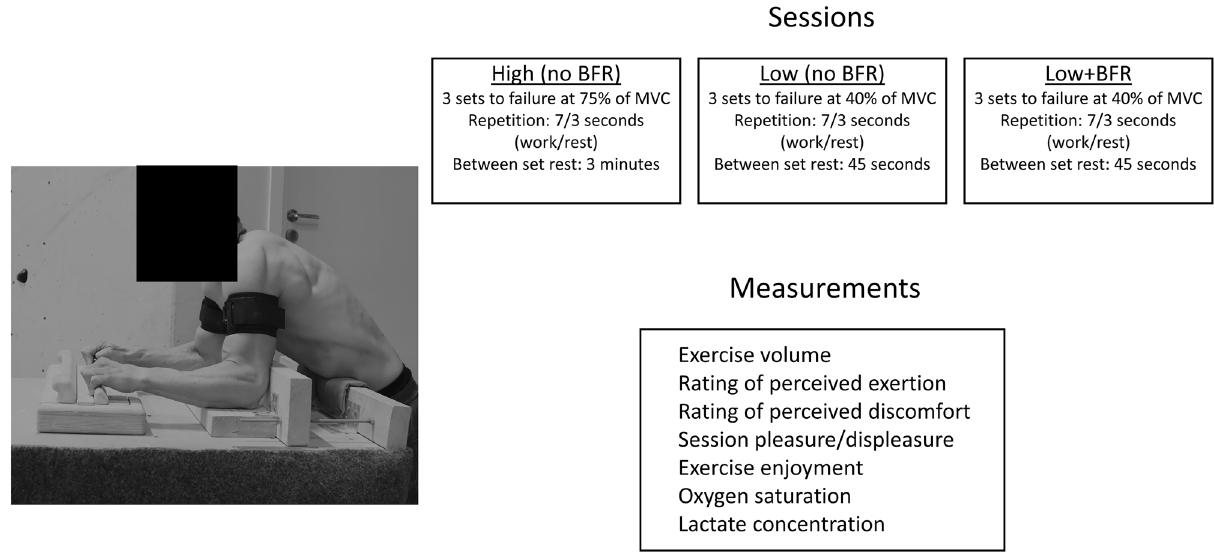
Figure 1. Accumulated training volume (kg × sec) in set 1, set 1 + 2, and set 1 + 2 + 3 in the three sessions Low, Low + BFR, and High. Data presented as mean and standard deviation. * p < 0.05, # p < 0.01.